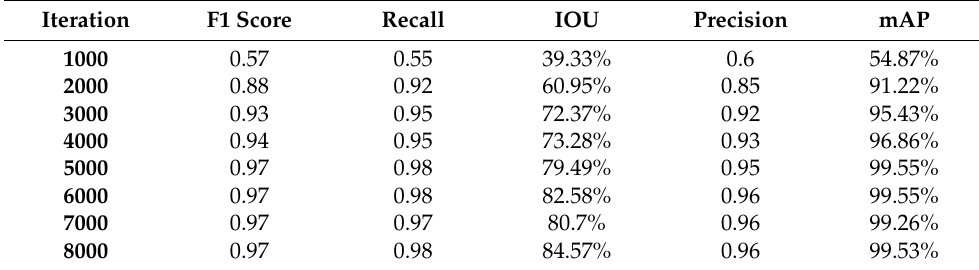
Table 5. Training results of F1-score, recall, IOU, precision, mAP.